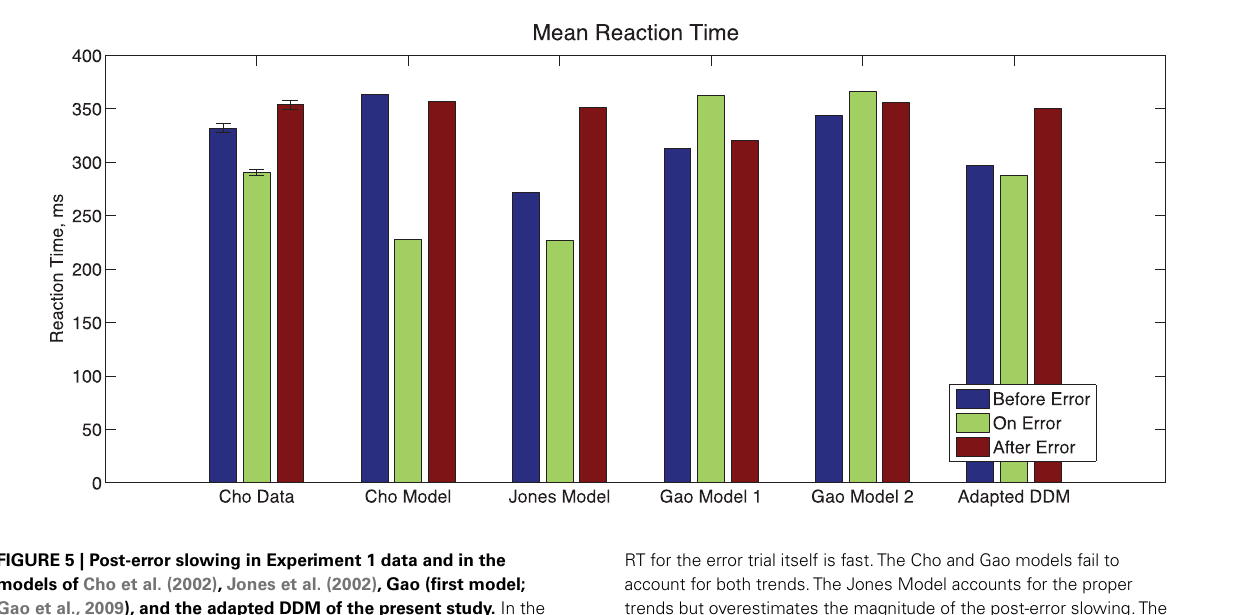
FIGURE 5 | Post-error slowing in Experiment 1 data and in the models of Cho et al. (2002), Jones et al. (2002), Gao (first model; Gao et al., 2009), and the adapted DDM of the present study. In the Experiment 1 data, the mean RT for a trial immediately following the error trial is slower than that for the trial before the error, and the mean